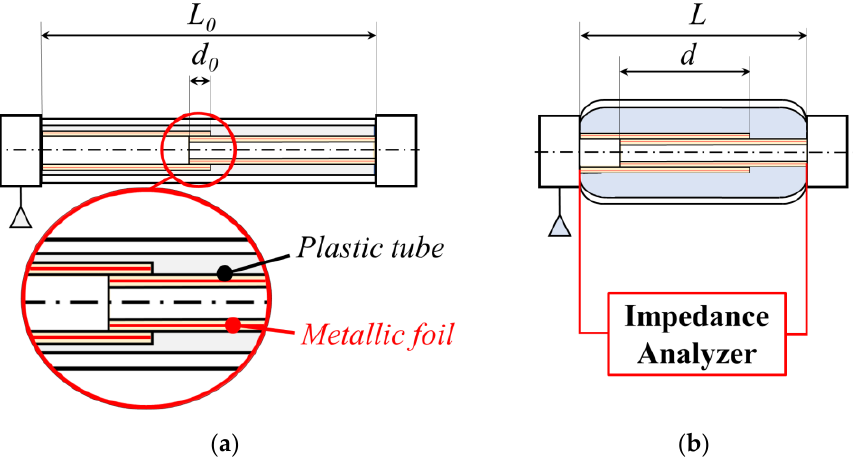
Figure 3. Schematic of the proposed MKM. Panel ( a ): the muscle at rest with length L 0 . Here, d 0 indicates the overlapping of the two cylindrical capacitor foils. In the inset, a magnification of the cylindrical capacitor structure is visible; Panel ( b ) the muscle compressed for an actual length L < L 0 and d > d 0 .